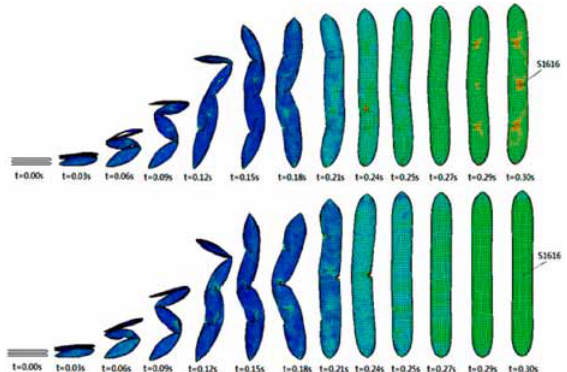
Fig. 10. Equivalent stress distributions in the